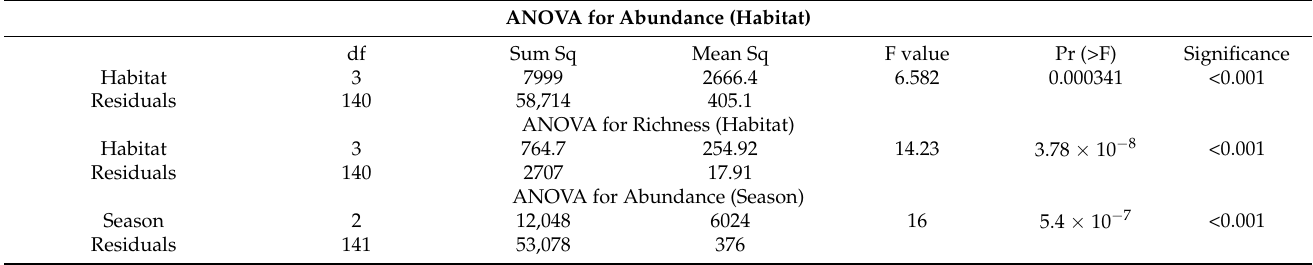
Figure 5. ANOVA showing that there was a significant difference between habitat in terms of bird abundance ( a ) and richness ( b ); CL = Cropland, RA = Residential areas, SF = Sal Forest, and WB = Water Body. Check Table 2 for more details. Table 2. Table showing the results—(a) One-way ANOVA test for both abundance and richness. Additionally, pairwise comparisons—(b) Tukey’s HSD test for bird richness and abundance across the habitat and season are represented below the ANOVA results; CL = Cropland, RA = Residential areas, SF = Sal Forest, and WB = Water